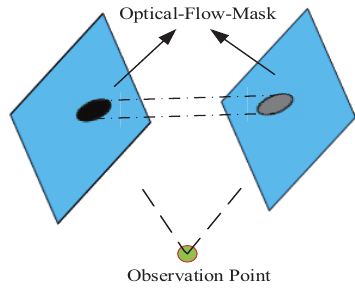
Figure 3. Optical flow